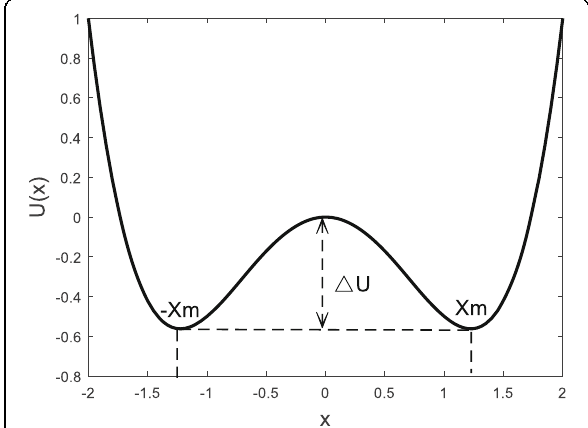
Fig. 2 Potential function of bistable